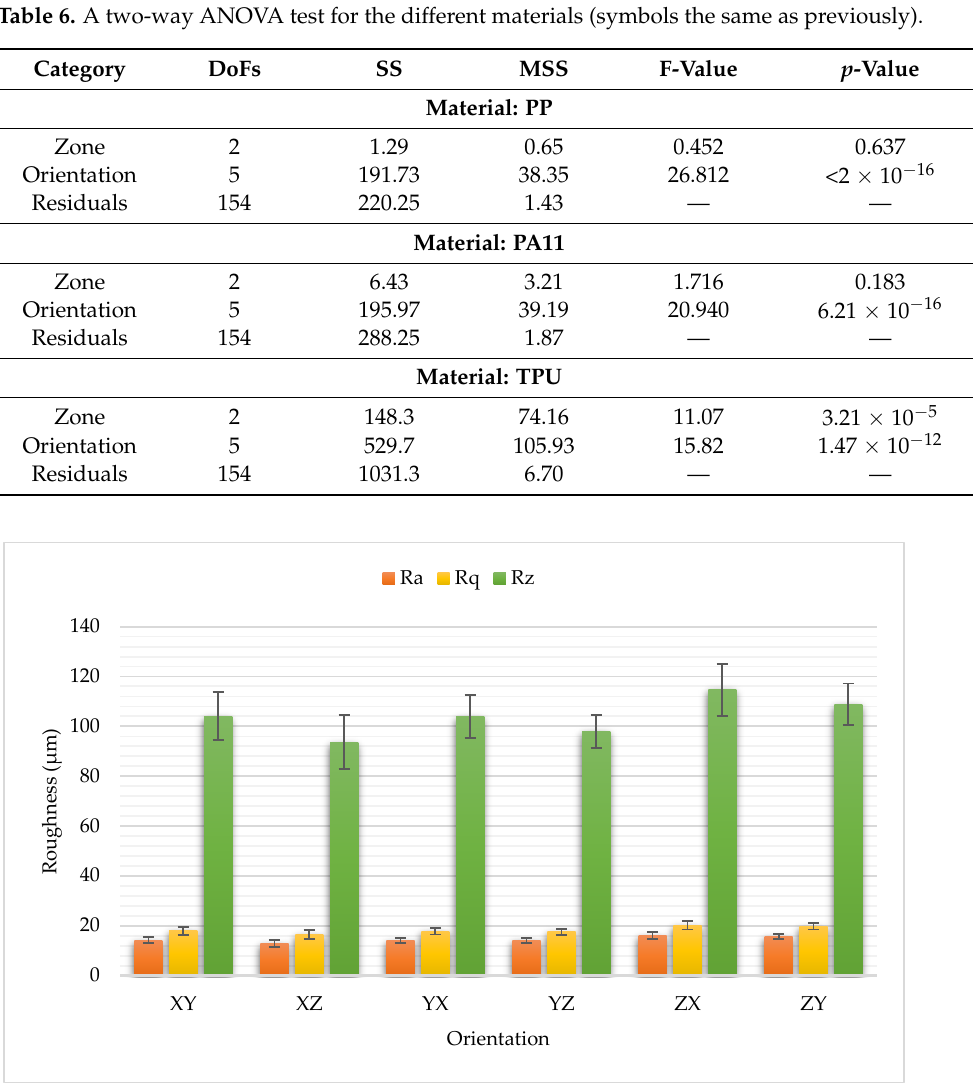
Figure 13. The average roughness and standard deviation of the polypropylene (PP) samples grouped by orientation.